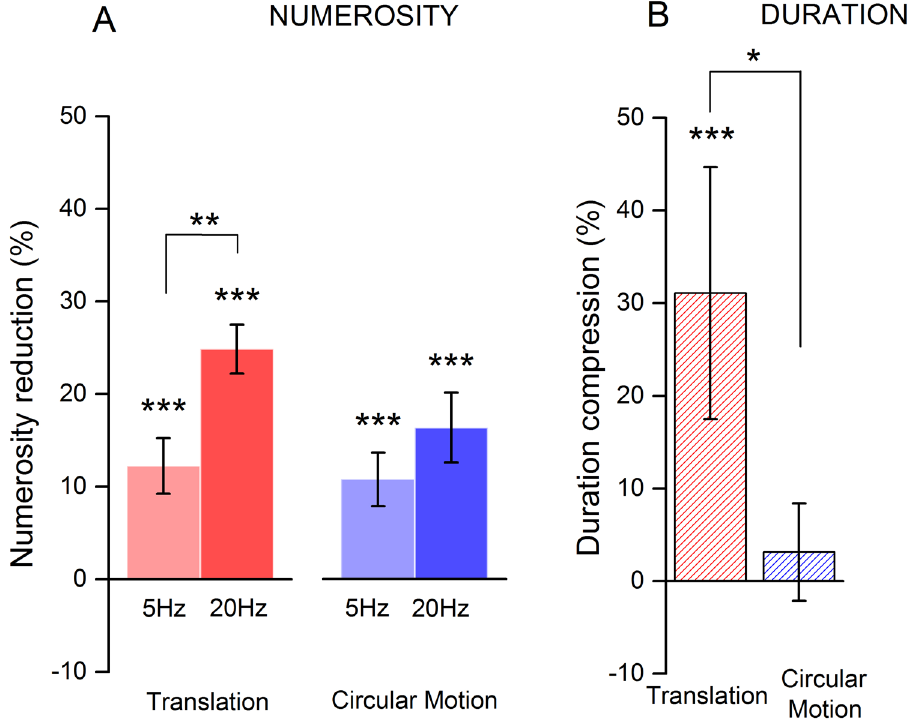
Figure 3. Average numerosity compression for adaptation to translational or circular motion. Panel A: Reduction in perceived numerosity induced by adaptation to translational (in red) or circular motion (in blue). In all conditions, numerosity reduction was calculated as the difference between post-adaptation and baseline PSEs, normalized by the baseline. Adaptation to fast translational motion strongly compressed perceived numerosity by on average 20–25%. Fast rotational motion yielded a robust compression (around 15–17%) but it was smaller than that induced by fast translation. Perceived numerosity was also distorted by adaptation to slow circular and translational motion, with the two motion profiles providing similar compression (around 10%). Panel B: Reduction of stimulus perceived duration induced by adaptation to fast translational (red hatched bar) or circular (blue hatched bar) motion (data from Fornaciai et al . 29 ). Whilst adaptation to translation robustly affected perceived duration and numerosity (in both cases providing a compression of about 20–30%), adaptation to circular motion significantly distorted the estimates of perceived numerosity without affecting perceived duration. Asterisks above each bar refer to tests comparing pre- and post-adaptation PSEs. Asterisks between bars refer to tests comparing the magnitude of adaptation across different conditions. Error bars represents S.E.M. * p < 0.05, ** p < 0.01, *** p <